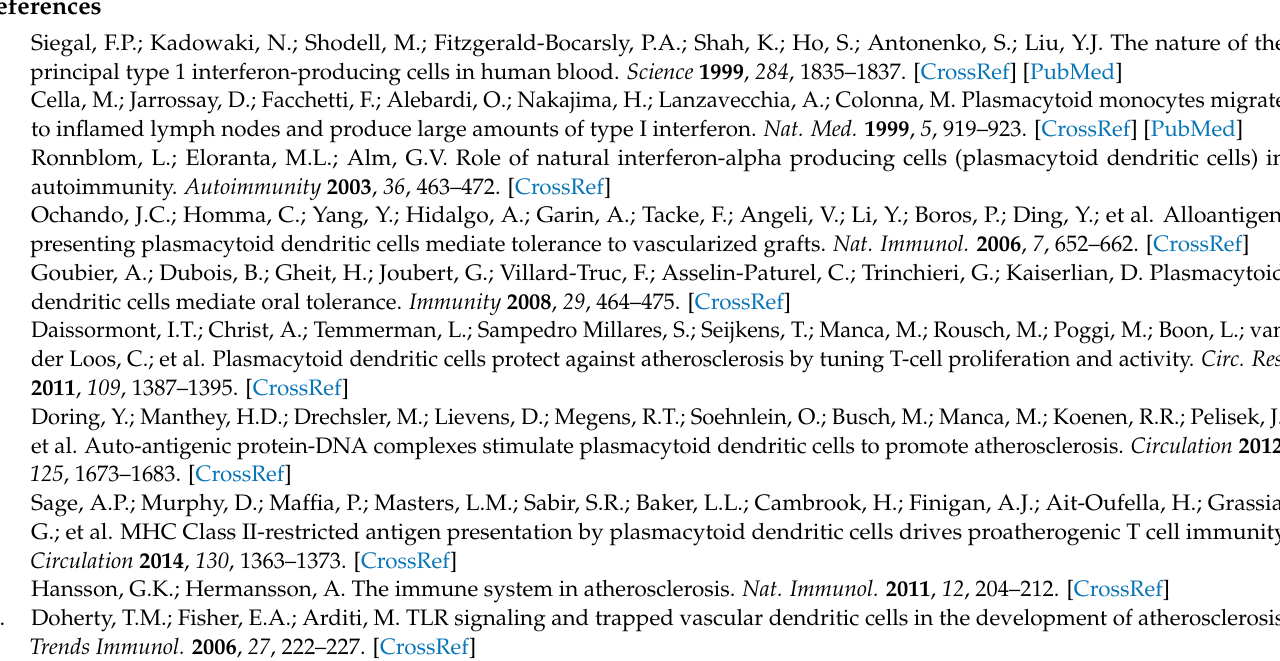
Figure S3: Transcriptional profiling of oxLDL-incubated and CpG-stimulated